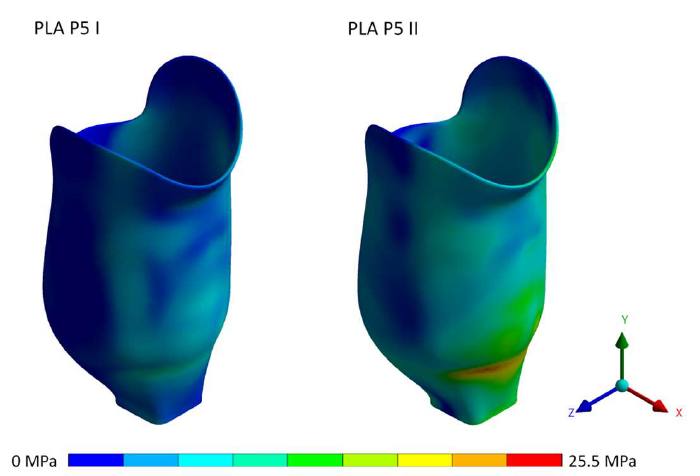
Figure 6. Von-Mises stress distribution for the PLA socket at proof test force.